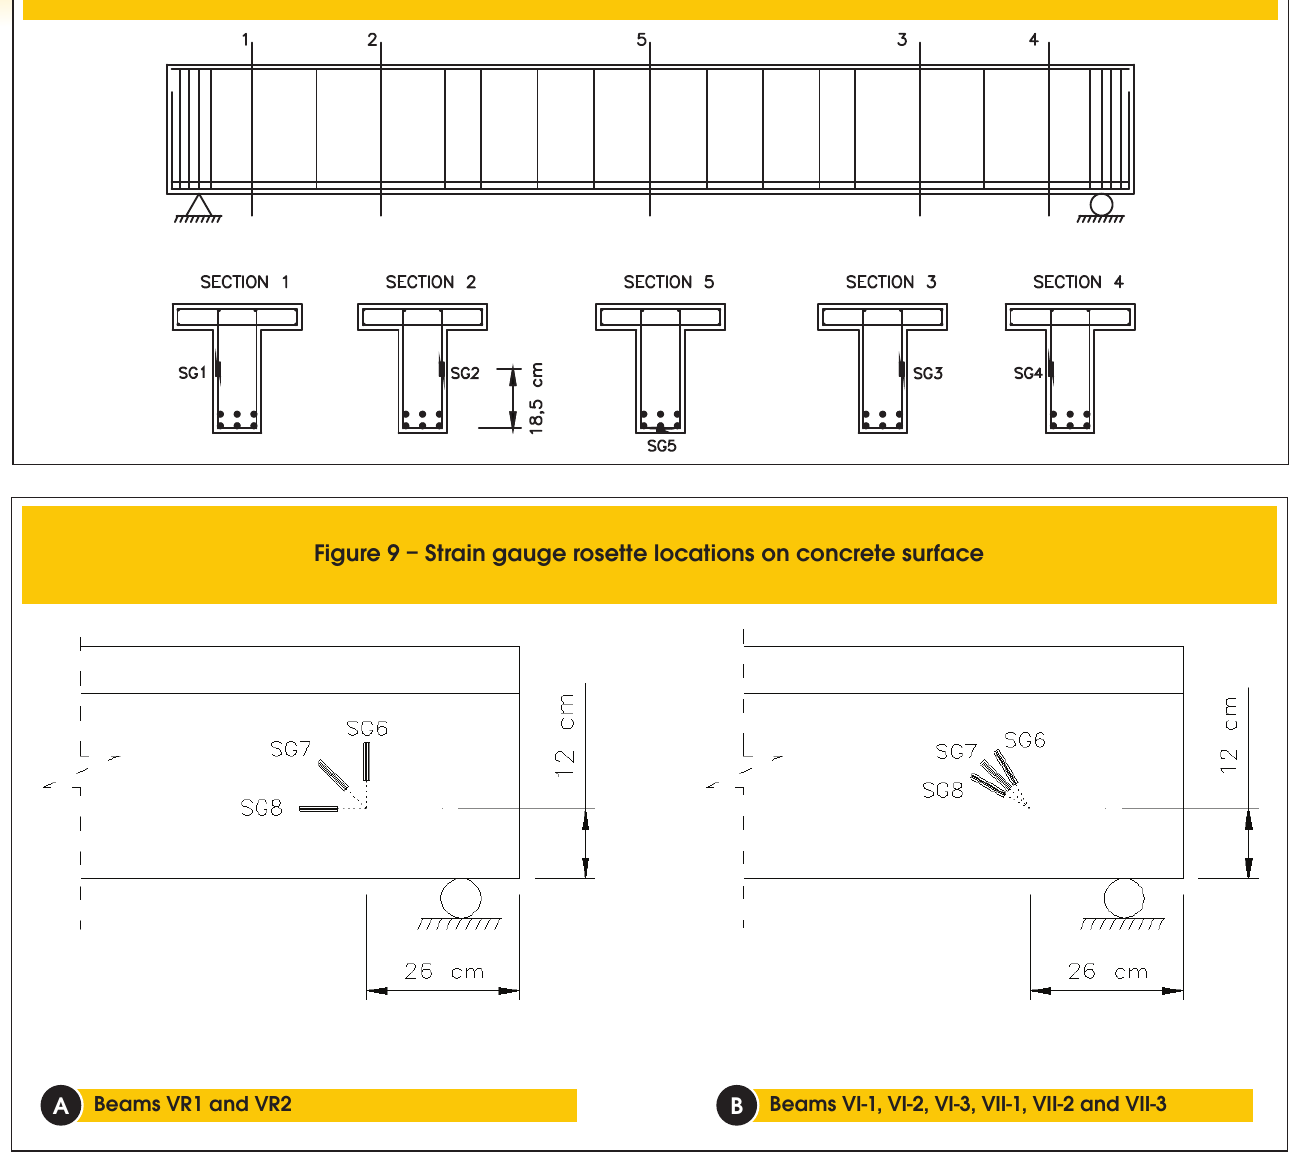
Figure 8 – General view of strain gauge locations on steel stirrups and longitudinal bars of series II, distance from support: section 1=0.15 cm, section 2=0.45 cm; section 5=middle and other sections are symmetric